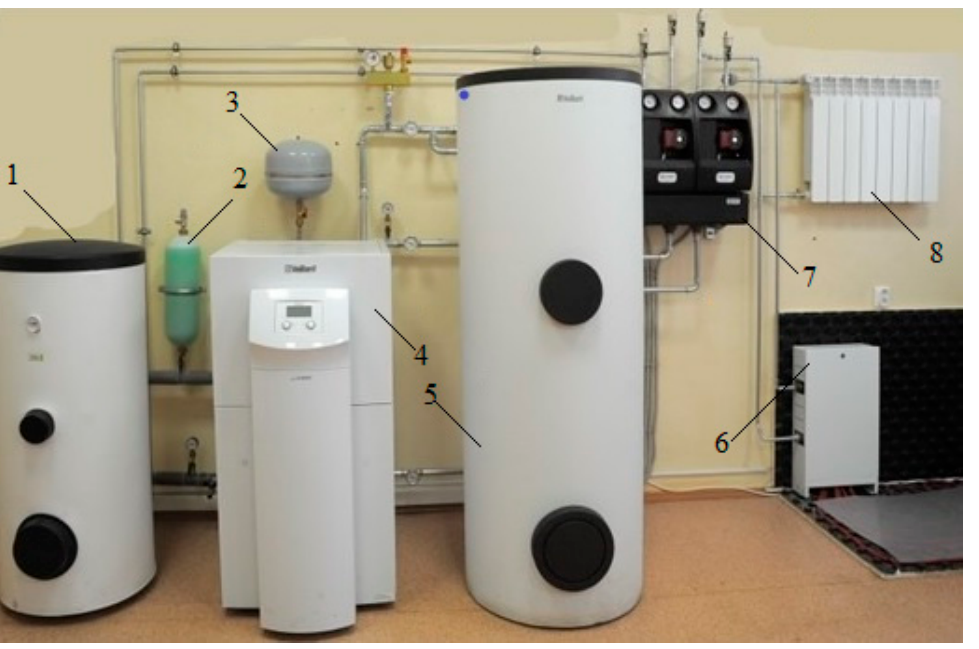
Figure 1. Research heat pump plant. 1—cold water tank, 2—expansion tank, 3—membrane tank, 4—heat pump, 5—hot water tank, 6—distribution manifold for underfloor heating, 7—pumps and water collector, 8—heating radiator.